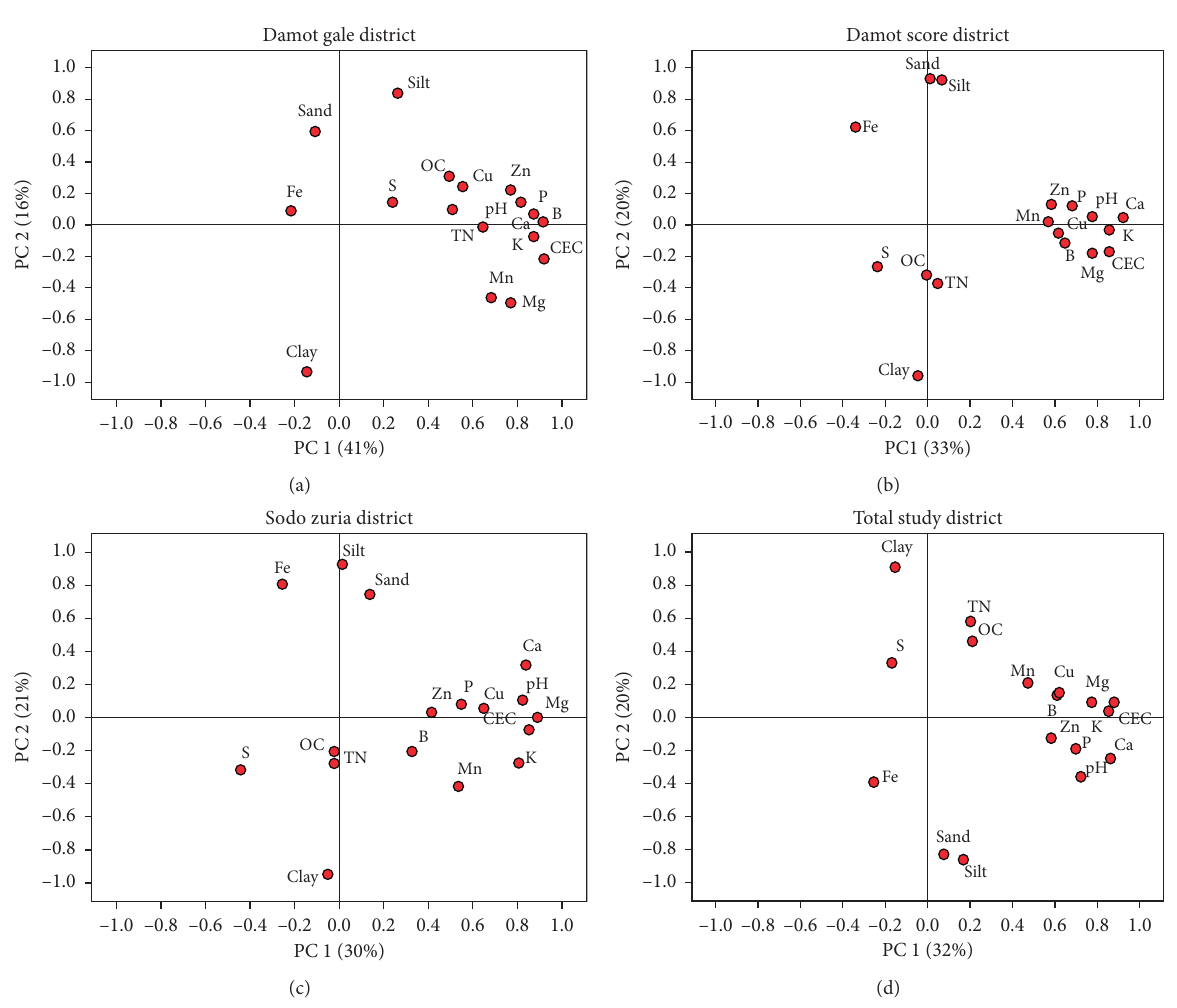
Figure 3: Component plot of soil properties of Damot Gale (a), Damot Sore (b), Sodo Zuria (c), and total study area (d).